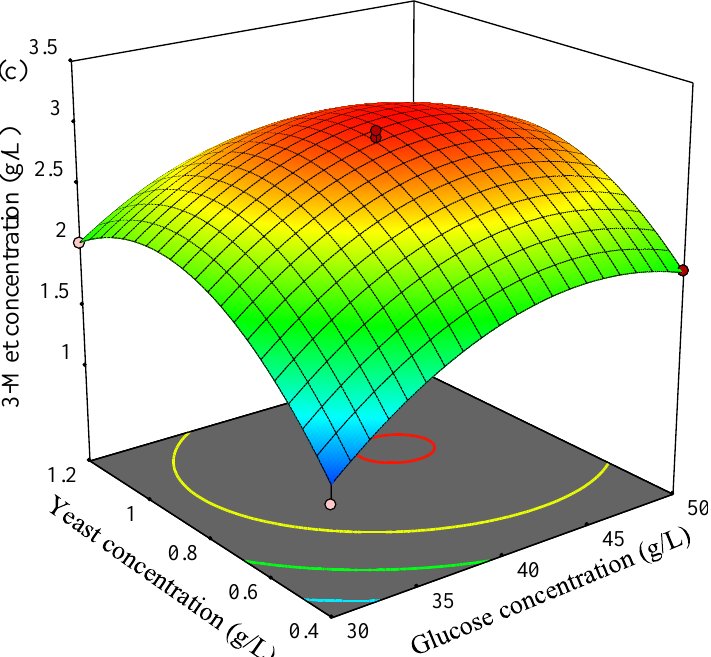
Figure 3. The 3D surface interaction of variable (time point of L-Met addition, glucose concentration and yeast extract concentration) on the 3-Met concentration–response using the BBD. ( a ) Time point of L-Met addition and glucose concentration; ( b ) time point of L-Met addition and yeast extract concentration; ( c ) glucose concentration and yeast extract concentration.